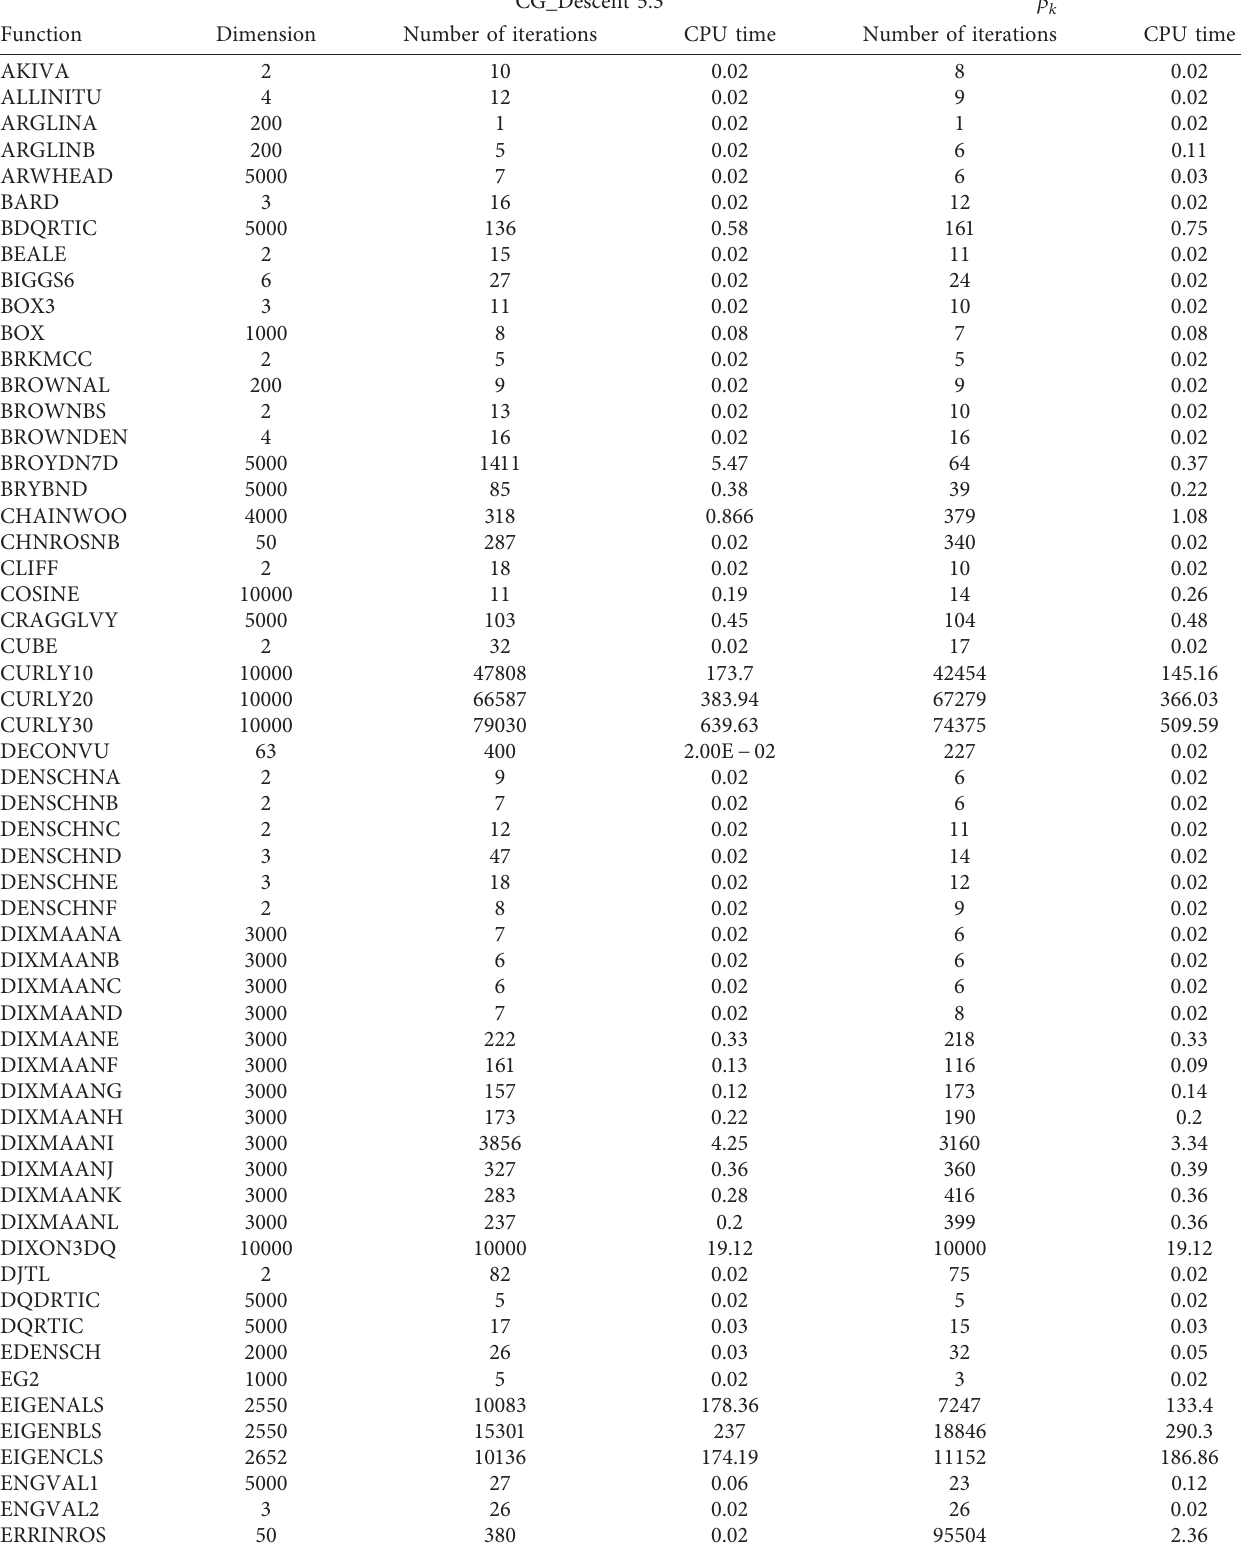
Table 1: The test